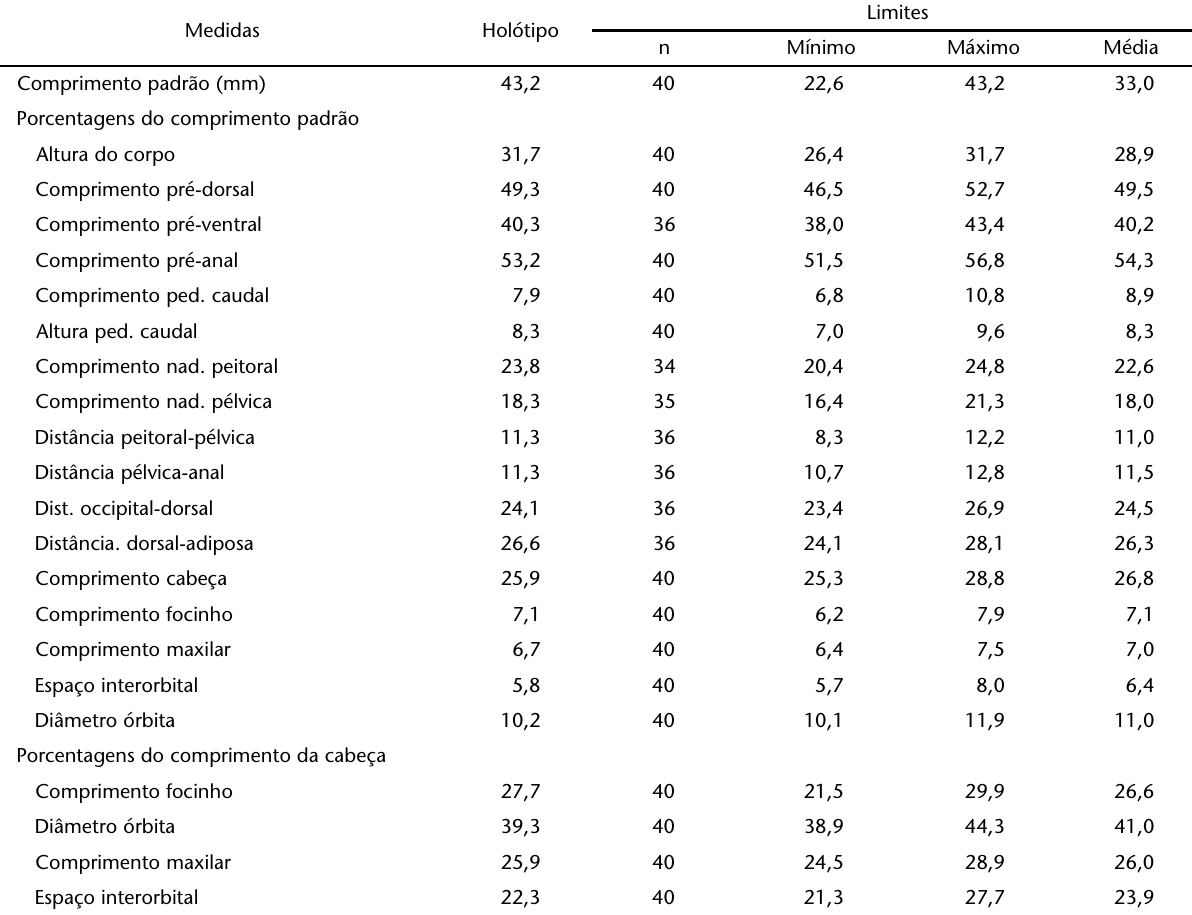
Tabela VII. Medidas de P. simulatu s sp. nov. , holótipo ROM 72774. (n) Número de exemplares, incluindo o